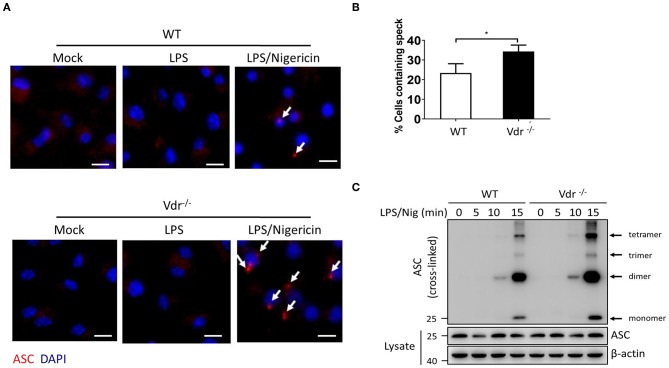
Vitamin D receptor blocks NLRP3 oligomerization and ASC speck formation. (A,B) Representative immunofluorescence images and quantification of endogenous ASC specks (arrows). The data show representative results from three combined independent experiments. Scale bar, 10 μm. (C) ASC oligomerization induced by the indicated stimuli at 0, 5, 10, and 15 min in WT and Vdr−/− macrophages primed with LPS. Data are presented as the mean ± SEM; *p < 0.05. Data in panel B is representative of three independent experiments.